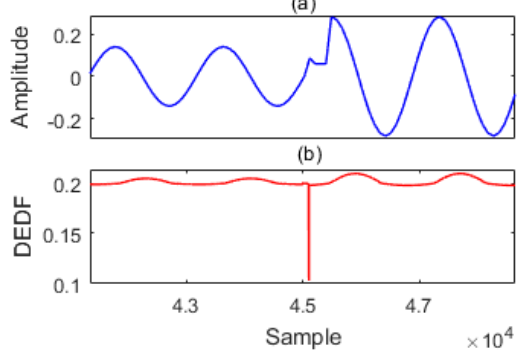
Figure 2. A sample signal analyzed by DEDF. ( a ) Sample signal as input of the DEDF; ( b ) output of the DEDF.